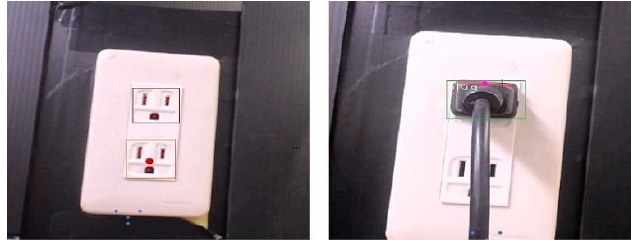
Figure 20. Object detection results using YOLO for the electric power socket (left-hand-side) and the electric power plug (right-hand-side). It is noted that the detected object areas are indicated as rectangle boxes.